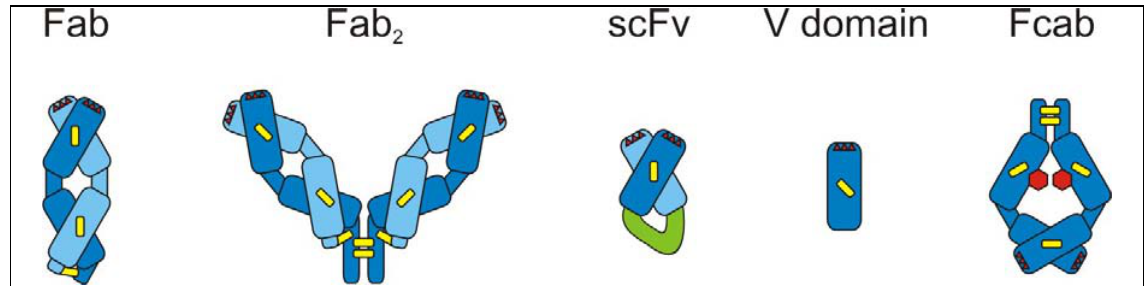
Figure 6. Schematic representation of different IgG-derived molecule formats. Heavy-chain derived polypeptides are indicated in dark-blue; light-chain derived polypeptides are indicated in light-blue; disulfide bonds are highlighted in yellow; the flexible linker peptide of scFv molecules is indicated in